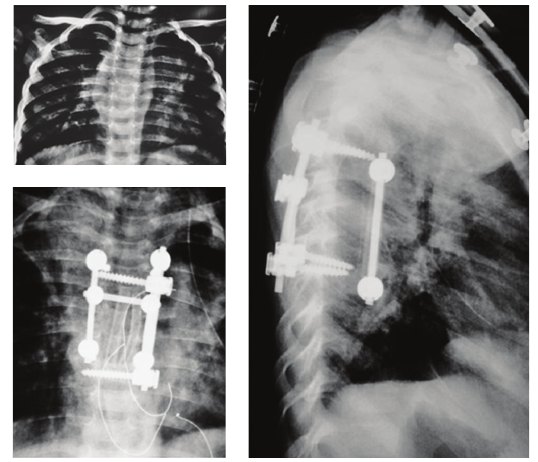
Figure 3: Preoperative and postoperative plain